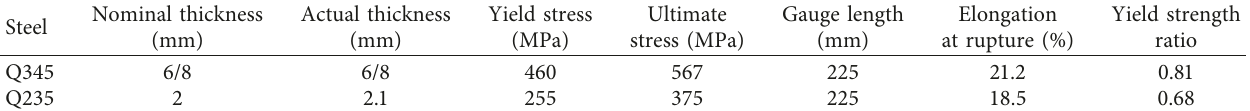
Table 1: Results of tensile coupon test.